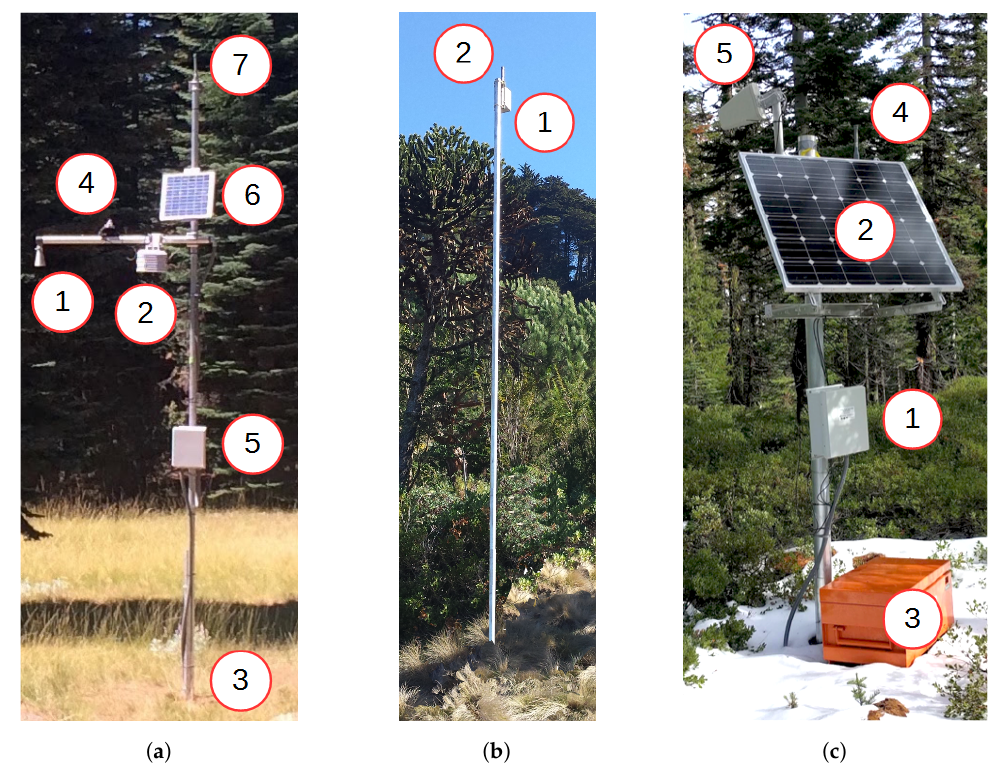
Figure 1. The hardware used. Circled numbers refer to specific modules of the system in Section 2.1. ( a ) Sensor station (Section 2.1.1); ( b ) Repeater node (Section 2.1.2); and ( c ) Base station (Section